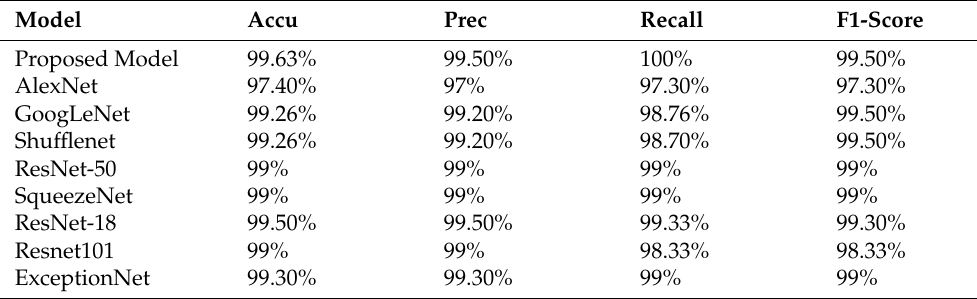
Table 8. Experimental results on binary BC